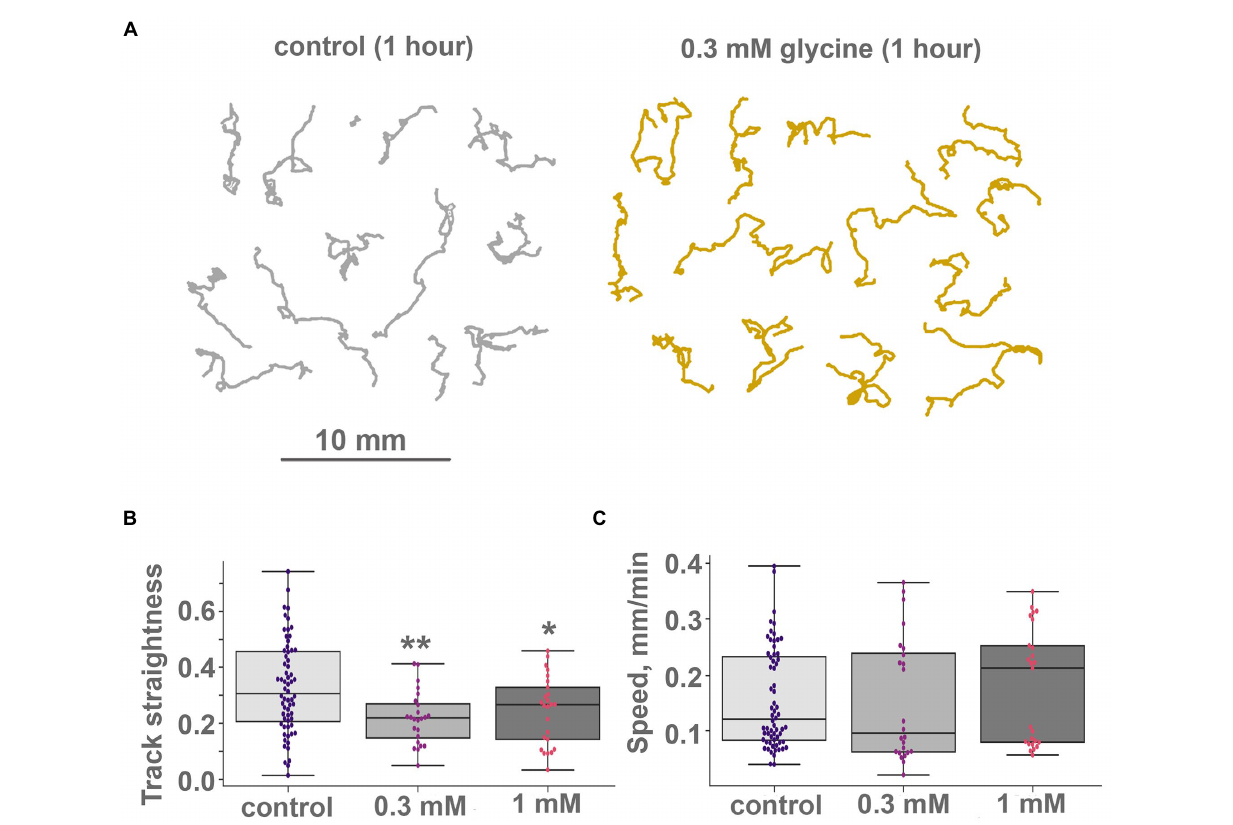
FIGURE 8 Glycine modulate locomotion in Trichoplax adhaerens . (A) Tracks of animals incubated for 1 h in 0.3 mM glycine (right) and ASW (left). After adding glycine, incubation tracks are squigglier than the control, but their length is unchanged. Tracks were recorded for 60 min. (B) and (C) Glycine